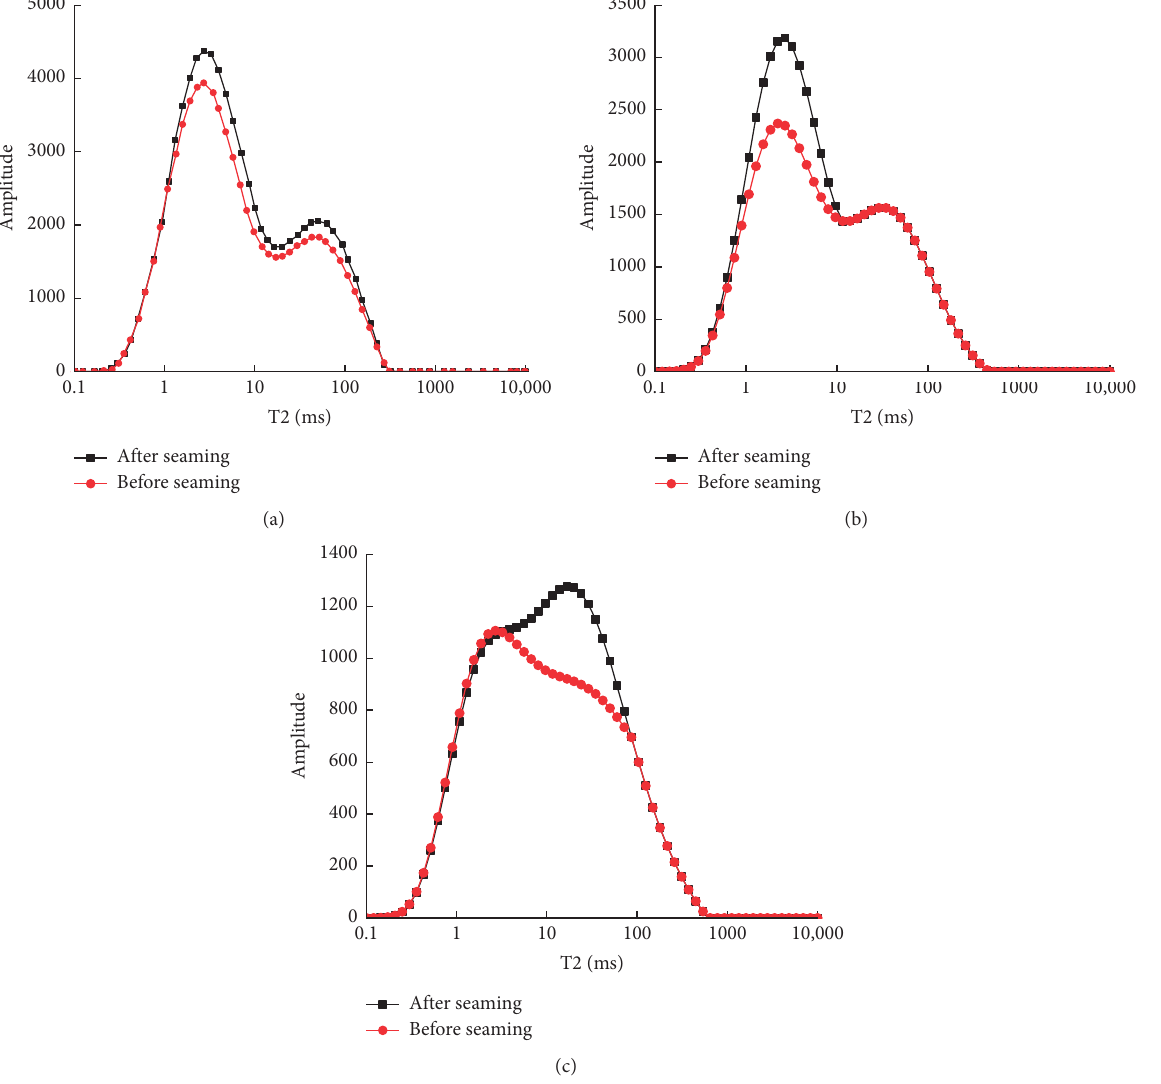
Figure 4: Nuclear magnetic resonance T2 spectrum of tight sandstone samples before and after fracturing. (a) HH56-15 core sample. (b) HH190-25 core sample. (c) JH36-4 core